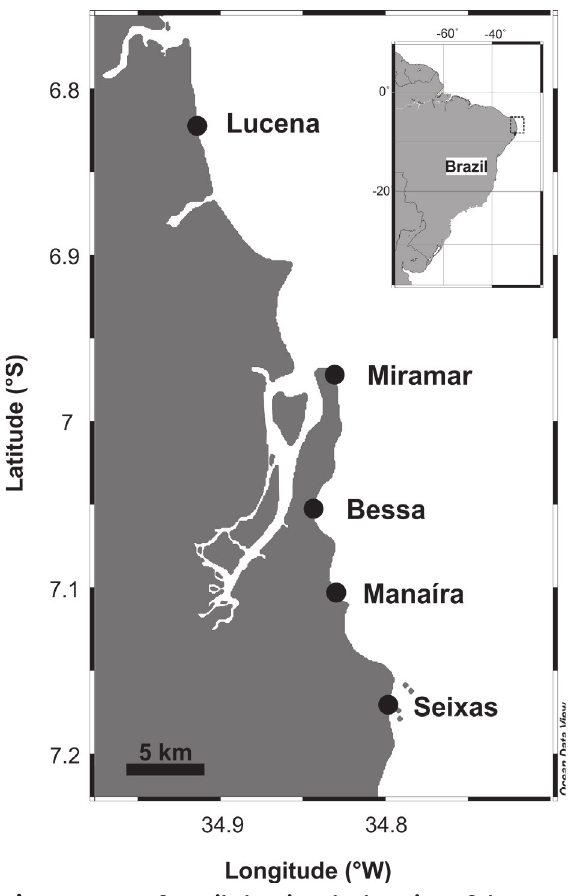
Figure 1. Map of Brazil showing the location of the beaches sampled. Generated using Ocean Data View software (Schlitzer